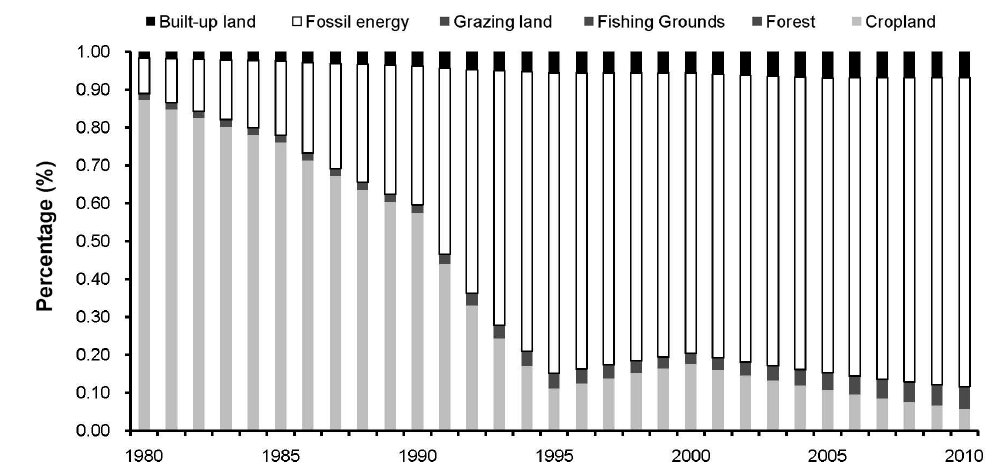
Figure 12. The proportion of EF per capita over years (figure drawn by the